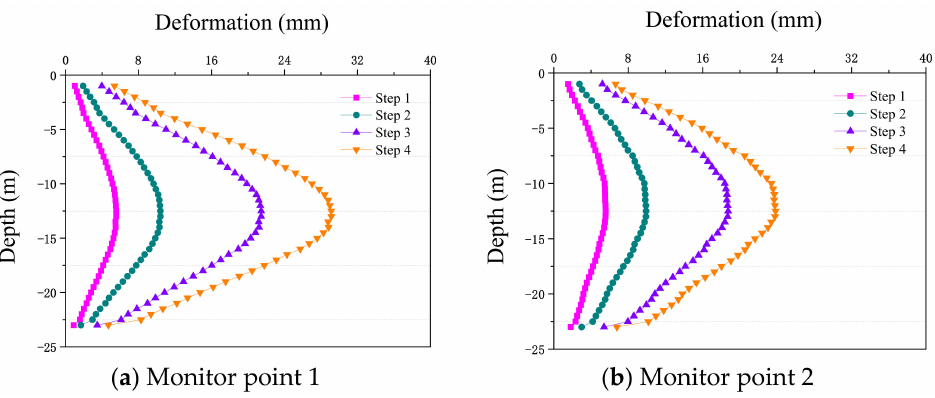
Figure 5. Horizontal displacement of the diaphragm wall through depth (monitored data). The horizontal displacement curve of diaphragm wall can be roughly divided into four types, and the “bow” curve is mainly reflected in the deep soft stratum, and it is most common when the supported retaining wall is not buried deep under the pit bottom. The middle of the wall body arches out into the pit, and there is no obvious reverse bending point under the foundation pit